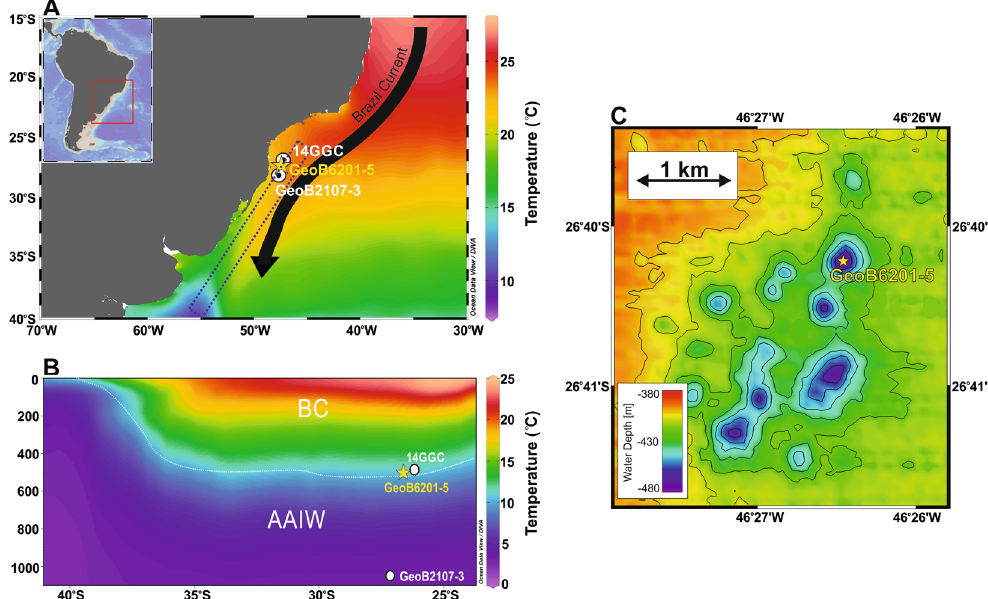
Figure 1. Location of core GeoB6201-5 (this study) and adjacent control cores GeoB2107-3 64 and 14GGC 30 . ( A ) Sea surface temperature in the western South Atlantic Ocean 65 showing the southward transport of warm tropical waters by the Brazil Current (red arrow). ( B ) Depth profile (dashed rectangle in A) showing water mass geometry in the western South Atlantic Ocean; Tropical Water (TW), South Atlantic Central Water (SACW) and Antarctic Intermediated Water (AAIW). White dotted line indicated the isopycnal σ = 27.1 marking the boundary between the lighter SACW and the denser AAIW 29,66 . Both TW and SACW are transported southward by the Brazil Current south of 20°S 67 ( C ) 25m-resolution bathymetric map of the pockmark field at the southern Brazilian Margin showing funnel-shaped depressions. Core GeoB6201-5 was collected from one of these depressions 28 . ( A ) and ( B ) were prepared using Ocean Data View software 68 (ODV - version, 4.7.9., http:// odv.awi.de, 2017). The bathymetric data in C were collected with a Hydrosweep DS2 system during the RV Meteor cruise M46/2(CIT). Processing and visualization was done with software Fledermaus Pro 7.7.6 (QPS; http://www.qps.nl). The map represents a grid with 25 m